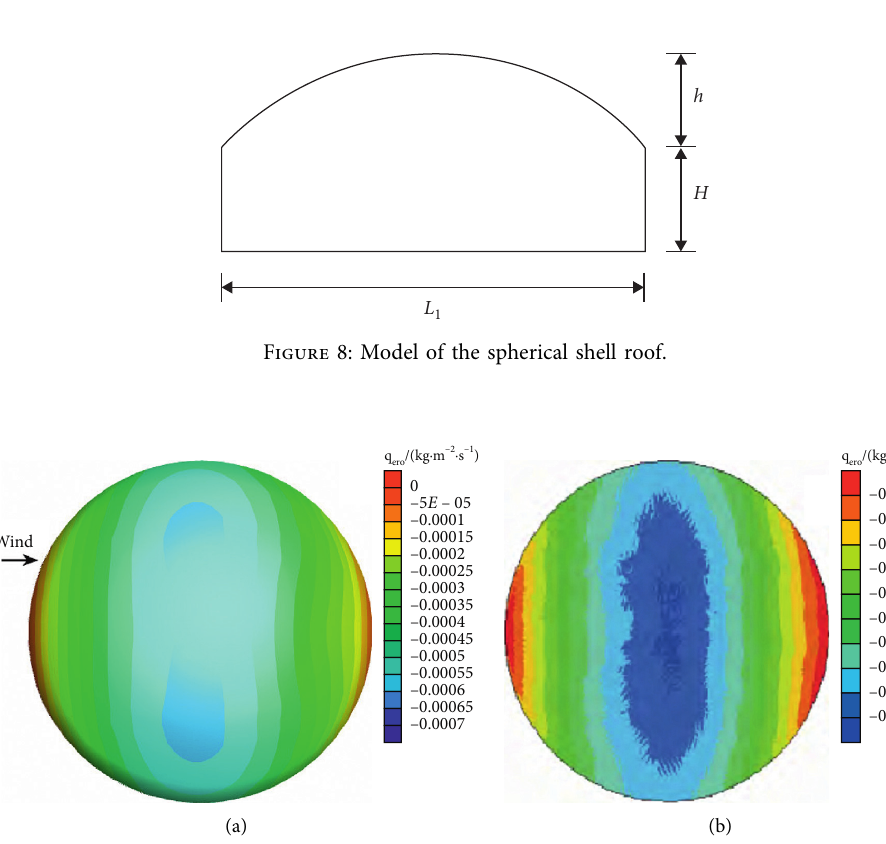
Figure 9: Comparison of the simulation results. (a) Simulation results of this paper. (b) Simulation results in the literature.